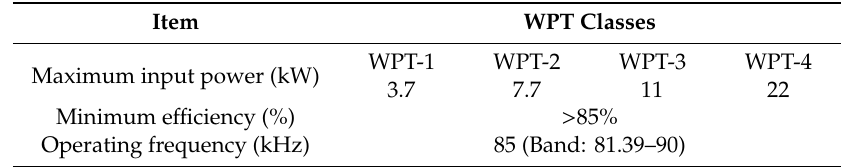
Table 2. Society of Automotive Engineers (SAE) International Standard (J2954) for the PHEV / EV WPT. Item WPT Classes WPT-1 WPT-2 WPT-3 WPT-4 Maximum input power (kW) 3.7 7.7 11 22 Minimum e ffi ciency (%) >